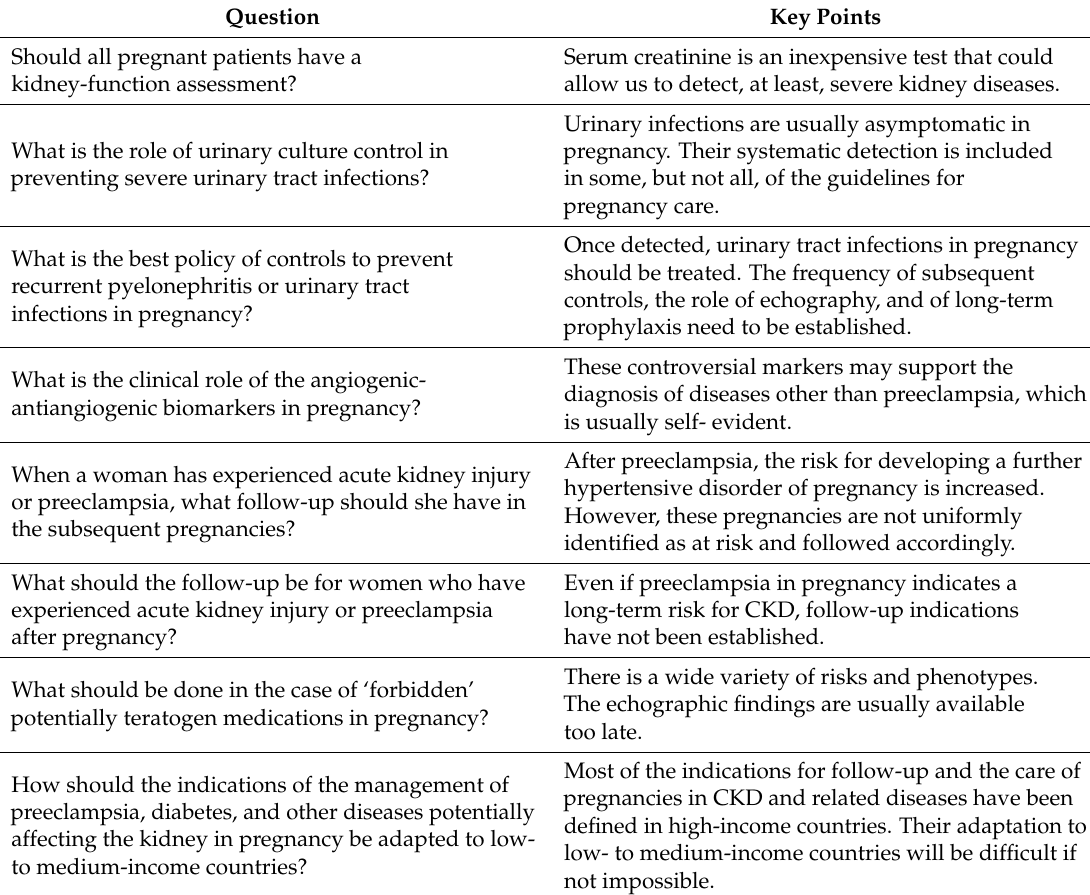
Table 3. Some clinical questions waiting for answers regarding pregnant women with acute kidney involvement or other diseases potentially involving the